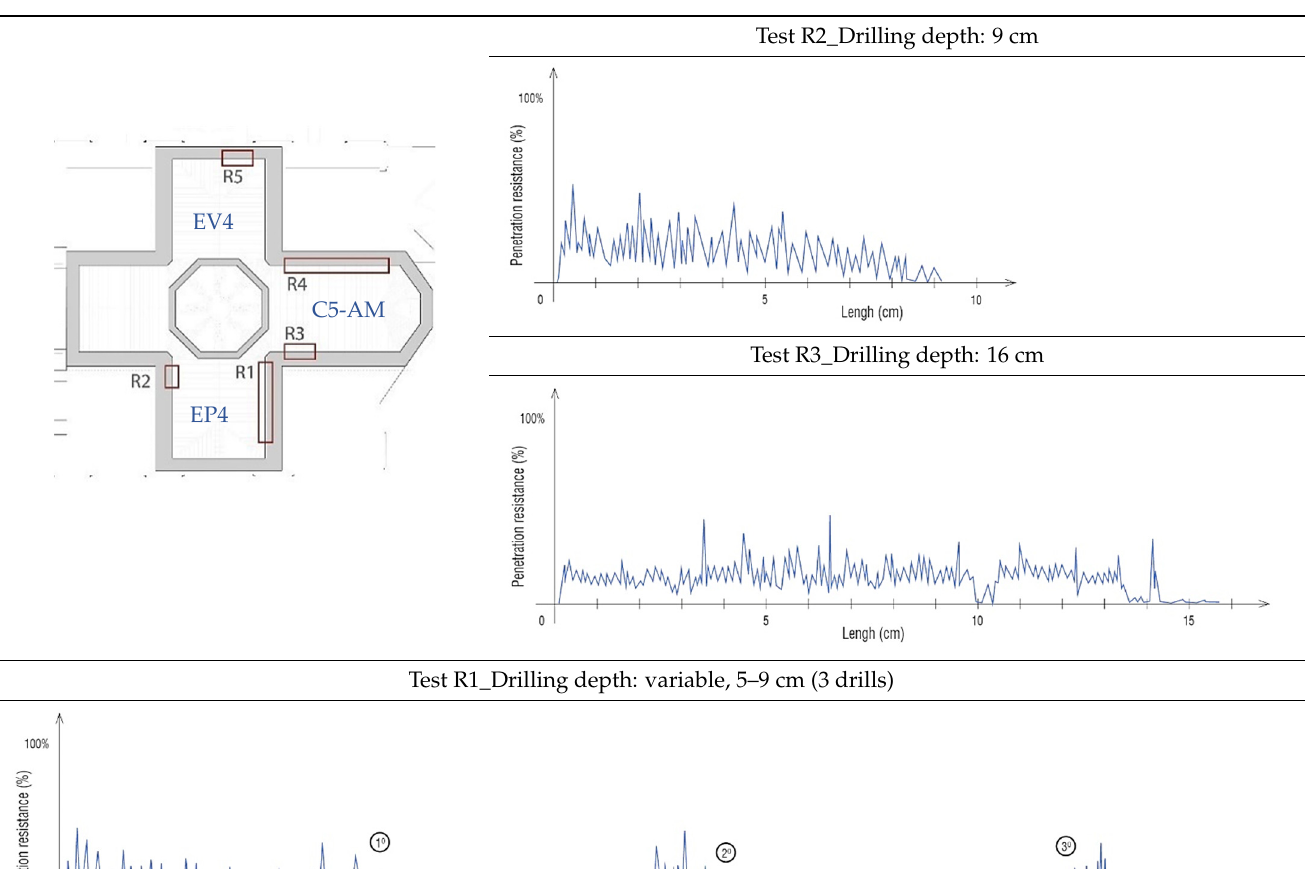
Table 3. Location and results of resistography tests.